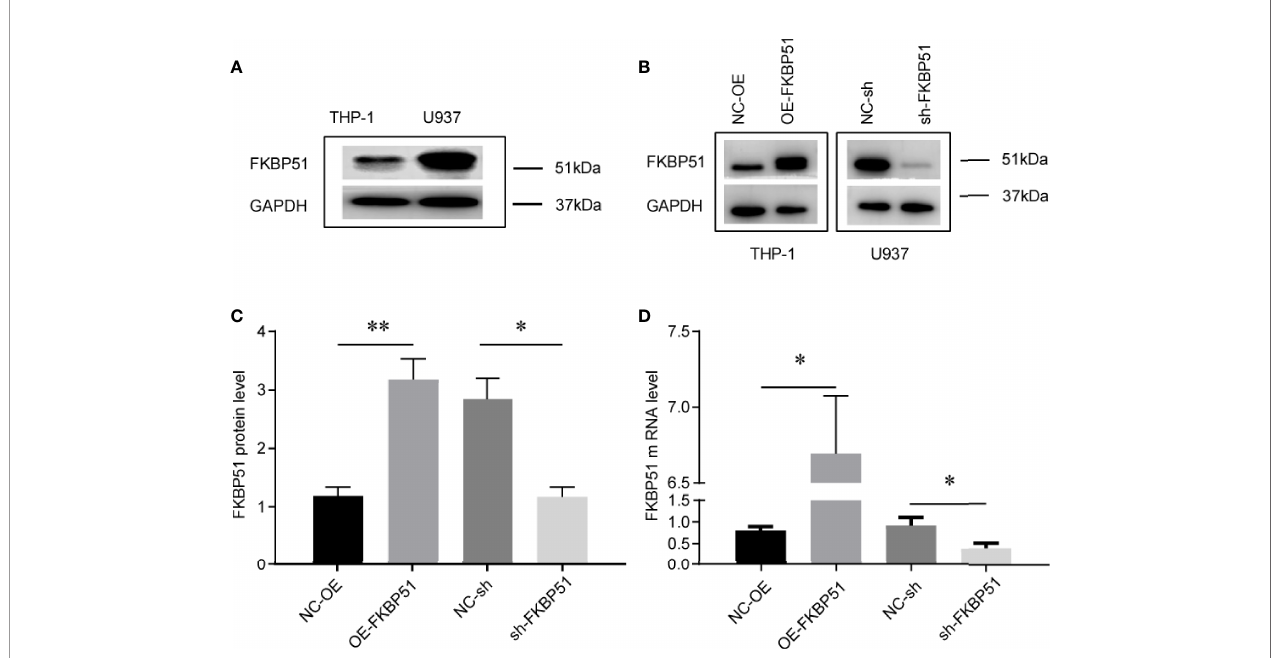
FIGURE 1 | Cell models of FKBP51 overexpression and knockdown were constructed and veri fi ed. (A) Relative expression of FKBP51 protein in U937 cells and THP-1 cells, which was con fi rmed by western blot analysis. (B-D) The expression of FKBP51 protein (B, C) and mRNA (D) were increased in FKBP51 over- expressed THP-1 cells and decreased in FKBP51-knockdown U937 cells. GAPDH was used as internal control. Each experiment was performed in triplicate. OE- FKBP51, FKBP51-overexpressing THP-1 cells; NC-OE, negative control for OE-FKBP51; sh-FKBP51, shRNA-FKBP51-treated U937 cells; NC-sh, negative control for sh-FKBP51. The data are shown as the mean ± SD, and differences between groups were analyzed using independent sample Student ’ s t test and considered to be signi fi cant at p < 0.05 (* for p < 0.05, ** for p <